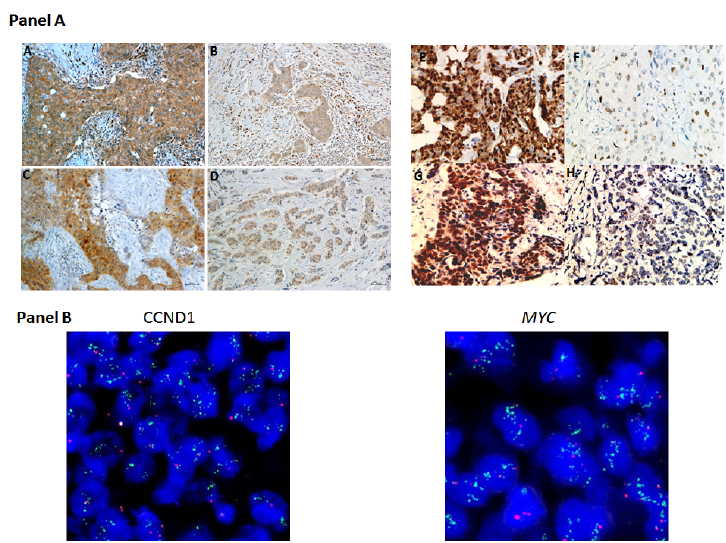
Figure 1. Representative images of immunohistochemical staining in BC tissues. Panel A displays representative images of biomarker expression. On the left: ( A ) Positive NOD-like receptor protein 3 (NLRP3) expression, ( B ) negative NLRP3 expression, ( C ) Positive Apoptosis-Associated Speck-Like Protein Containing a Pyrin and CARD domain (PYCARD) expression, ( D ) Negative PYCARD expression; On the right: ( E ) Positive CyclinD1 expression, ( F ) negative CyclinD1 expression, ( G ) Positive MYC expression, ( H ) Negative MYC expression. Panel B displays representative images of FISH experiments: ( on the left ) CCND1 gene amplification; ( on the right ) MYC gene amplification. For immunohistochemistry: original magnification, ×400. Scale bar = 20 μ m. Table 1. Tumor characteristics of 240 invasive breast cancer patients.